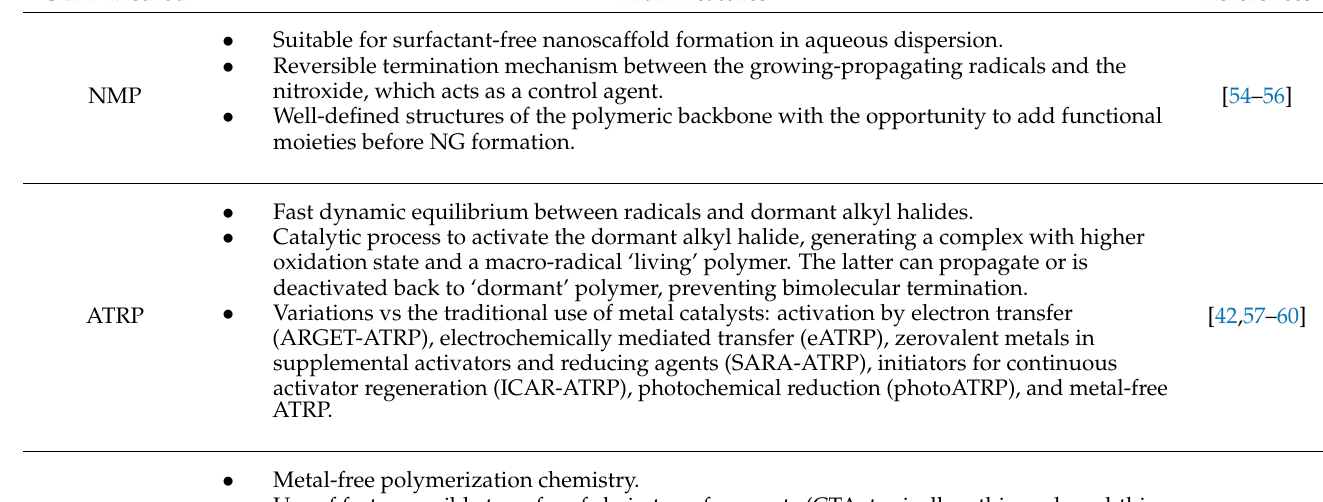
Table 1. Controlled/living radical polymerization (CLRP) techniques used in polymerization and NG design. CLRP Method Main